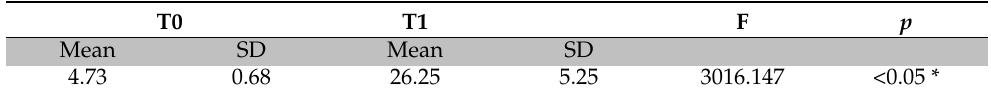
Table 11. Effect of within factor on task 4 (ESSE).